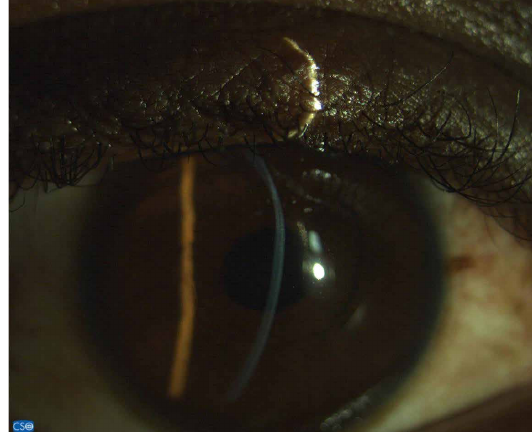
Figure 8 . An example of superior thinning observable using a slit